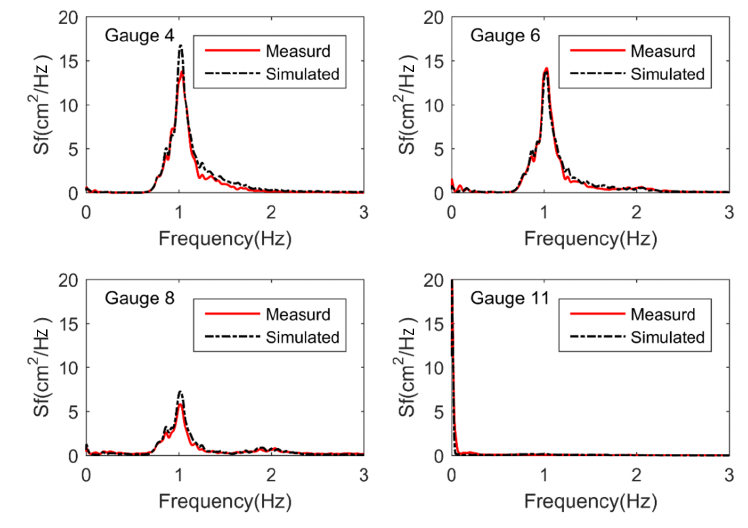
Figure 11. Comparison between the computed and measured wave energy spectra of four representative wave gauges for Case